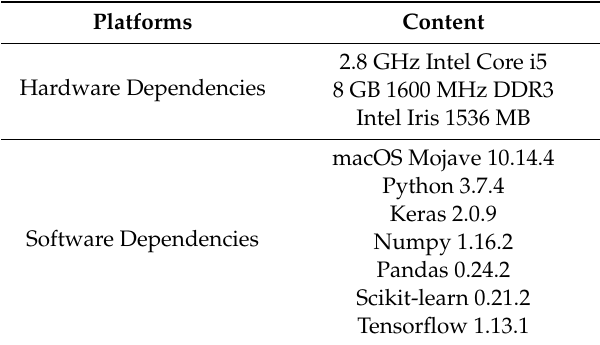
Table 1. The platforms of the environment.